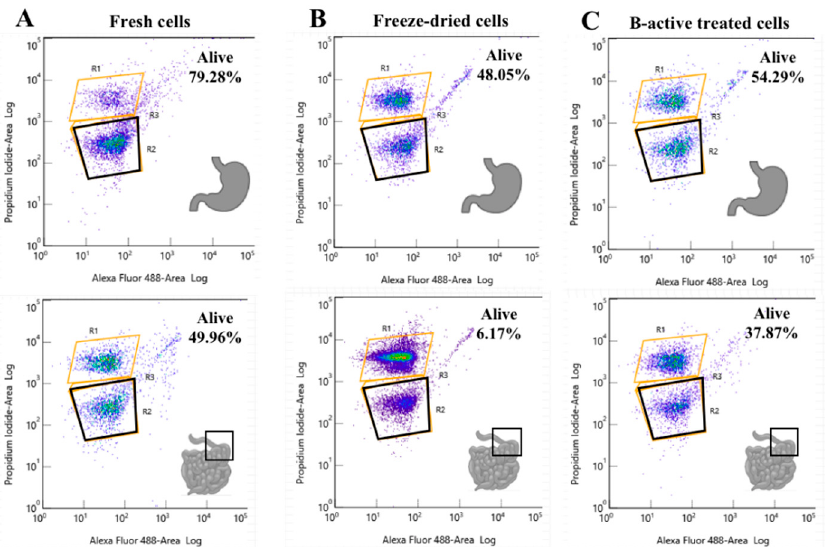
Figure 1. Real time detection of viability of Lp. plantarum HAC03 determined by flow cytometry after simulated stomach–duodenum passage. ( A ) Lp. plantarum HAC03 fresh cells cultured overnight in MRS broth at 37 °C. ( B ) Freeze-dried Lp. plantarum HAC03 cells rehydrated with 1 mL distilled water (DW) for 1 min at 25 °C. ( C ) Freeze-dried Lp. plantarum HAC03 cells mixed with B-active and rehydrated with 1 mL DW for 1 min at 25 °C. All live cells are gathered in the bottom black box, damaged cells in the lower orange box, and dead cells in the top orange box. The upper graphs represent HAC03 viability after the stomach passage, and the bottom graphs represent the viability after the duodenum passage. Viability tests were performed by a propidium iodine exclusion method.